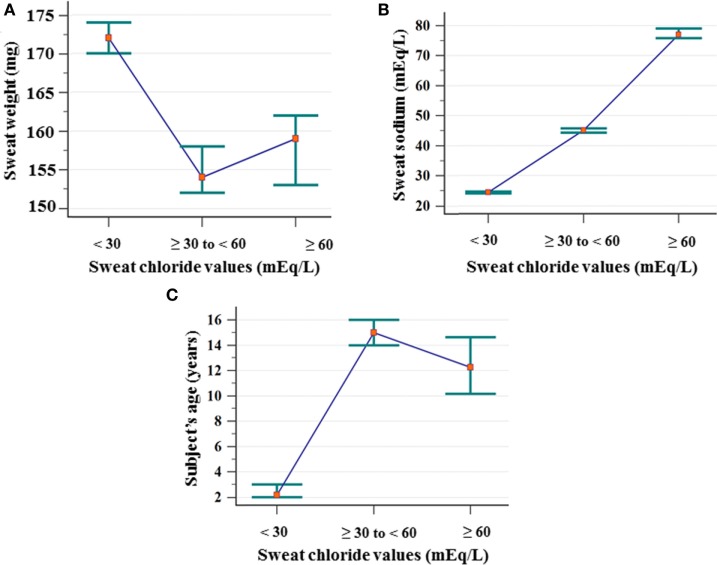
Association between the ST results considering chloride cutoff values and sweat weight (mg), sodium value (mEq/L), and subject’s age (years). (A) Sweat weight: (chloride <30 mEq/L) N = 3,249; mean of 175 ± 43; median of 172 (amplitude from 75 to 367); (chloride ≥30 to <60 mEq/L) N = 1,326; mean of 162 ± 41; median of 154 (amplitude from 78 to 299); (chloride ≥60 mEq/L) N = 702; mean of 164 ± 42; median of 159 (amplitude from 78 to 326). Chloride <30 mEq/L ≠ chloride ≥30 to <60 mEq/L, and chloride ≥60 mEq/L. (B) Sweat–sodium concentration: (chloride <30 mEq/L) N = 3,249; mean of 25.24 ± 7.03; median of 24.4 (amplitude from 10 to 68.5); (chloride ≥30 to <60 mEq/L) N = 1,326; mean of 45.82 ± 9.89; median of 45.11 (amplitude from 20.3 to 81.8); (chloride ≥60 mEq/L) N = 702; mean of 80.54 ± 17.98; median of 77 (amplitude from 42.9 to 149.7). All groups differ from each other. (C) Subject’s age: (<30 mEq/L) N = 3.233; mean of 6.66 ± 11.91; median of 2.17 (amplitude from 0 to 76.33); (chloride ≥30 to <60 mEq/L) N = 1,282; mean of 24.34 ± 21.74; median of 15 (amplitude from 0 to 85.58); (chloride ≥60 mEq/L) N = 621; mean of 21.27 ± 22.52; median of 12.25 (amplitude from 0 to 81.17). All groups differ from each other. Statistical analysis was performed by Kruskal–Wallis test. P-value for all analyses was <0.001. α = 0.05. The median is set in red marker and the 95% confidence interval is set in green line. mEq/L, milliequivalents per liter; ST, sweat test.